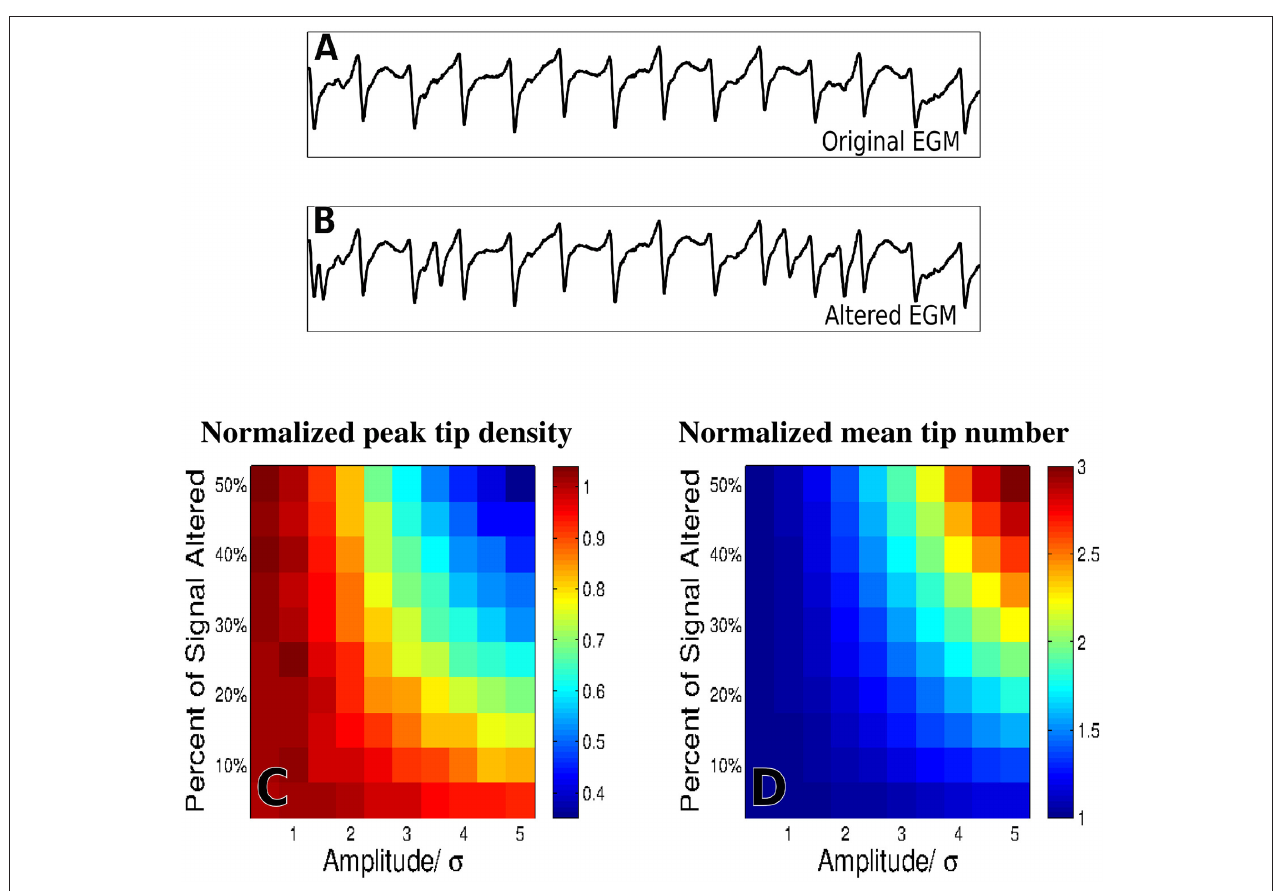
FIGURE 5 | The effects of adding false deflections to electrograms. A sample EGM before adding false deflections (A) and after altering 30% of the signal with deflections of amplitude/ σ = 3 (B) Normalized heat maps of peak tip density around the site of termination (C) , and mean number of tips (D) , as a function of both amplitude and frequency of added deflections are shown for 50